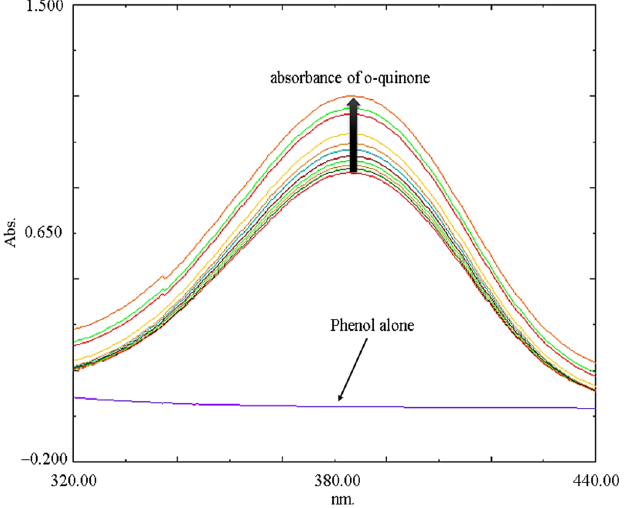
Figure 9. UV ‐ visible spectrum of absorption of o ‐ quinone in the presence of the pre ‐ synthesized [(Cl) 2 Mn(RCOOET)] in MeOH. [(Cl) 2 Mn(RCOOET)] in